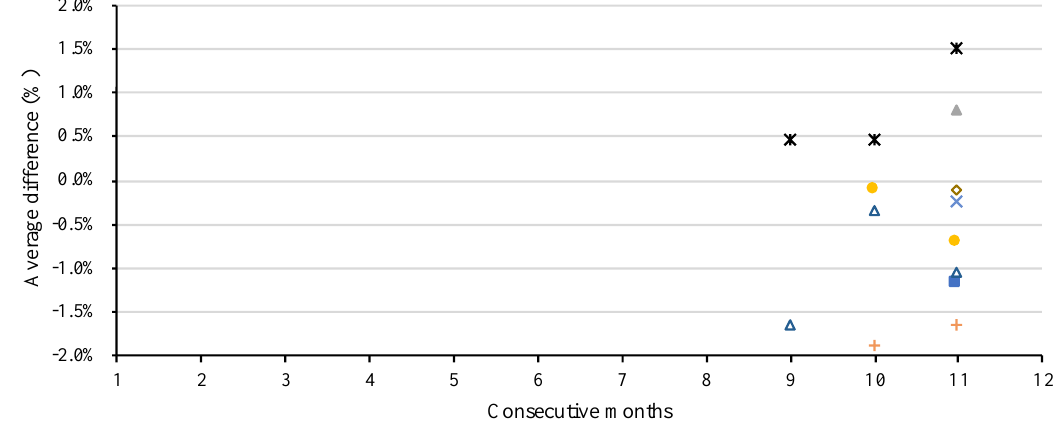
Figure 5. Heating slope coe ffi cient ( HS ) di ff erences (%) from the baseline coe ffi cient.